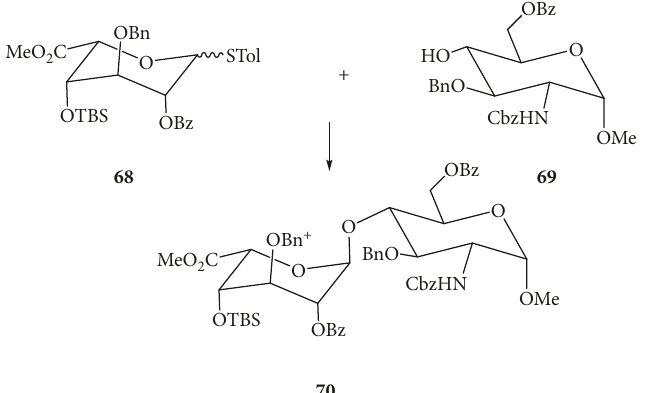
Scheme 21: Synthesis of the BA disaccharide fragment.